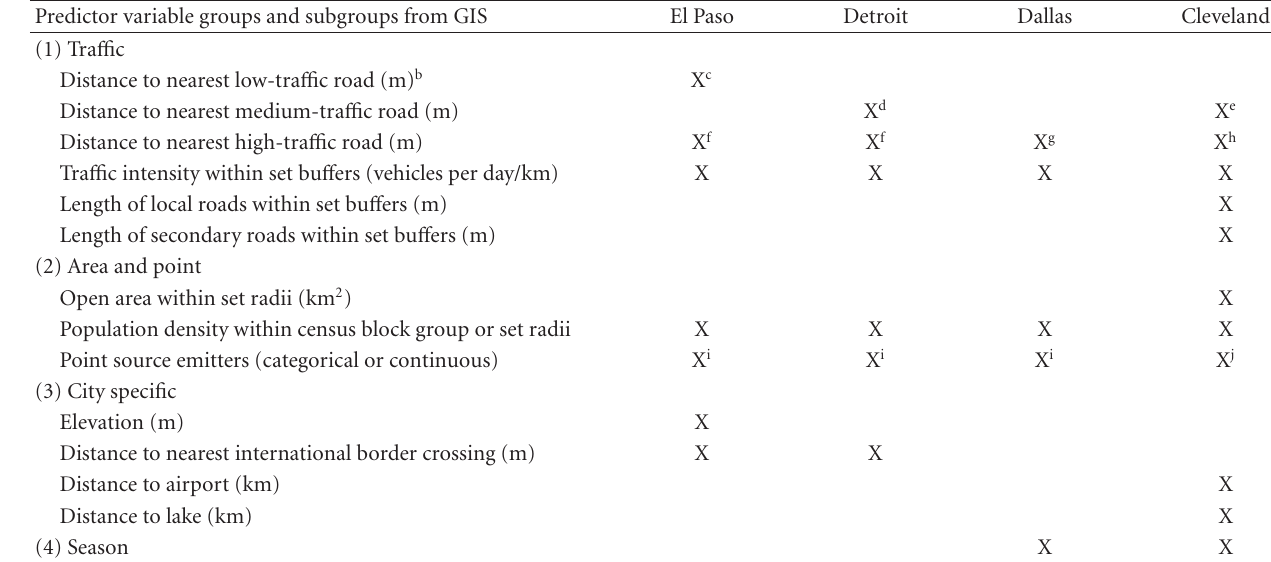
Table 1: Group types for potential predictor variables a